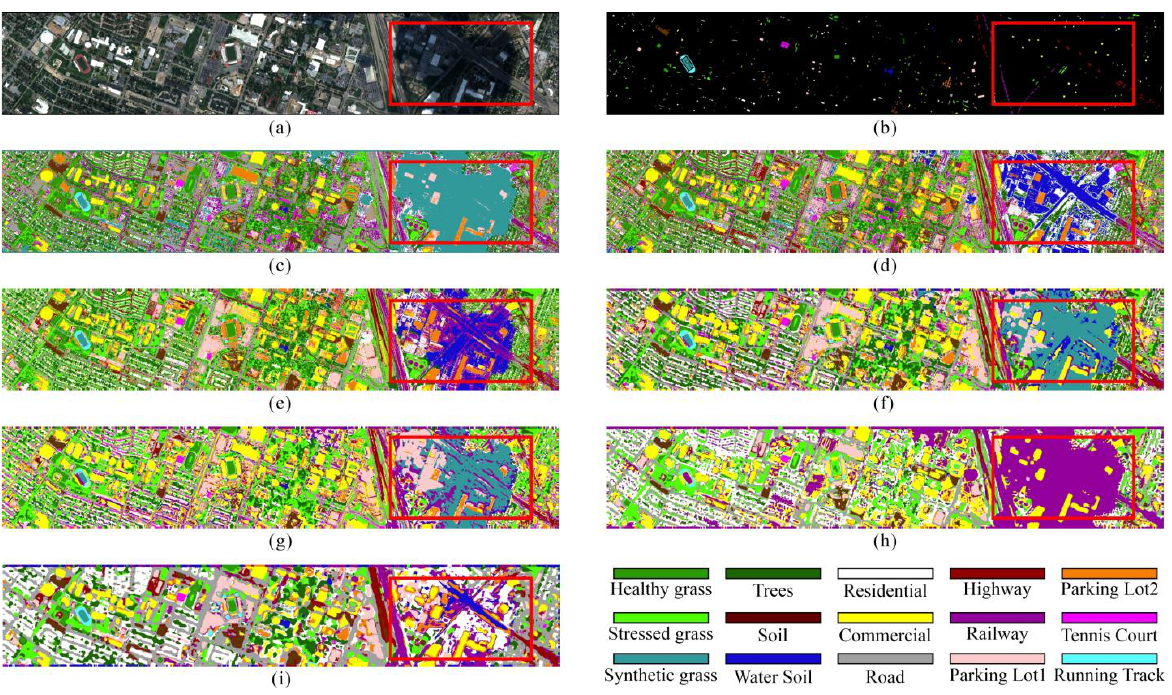
Figure 7. The classification results obtained using different methods on the Houston 2013 dataset. ( a ) Three-band composite image of the Houston 2013 HSI. ( b ) The ground truth of Houston 2013 HSI. The classification results of ( c ) SVM, ( d ) 1D CNN, ( e ) R2D, ( f ) 2D CNN, ( g ) 3D CNN, ( h ) MCM, and ( i ) LGSF.